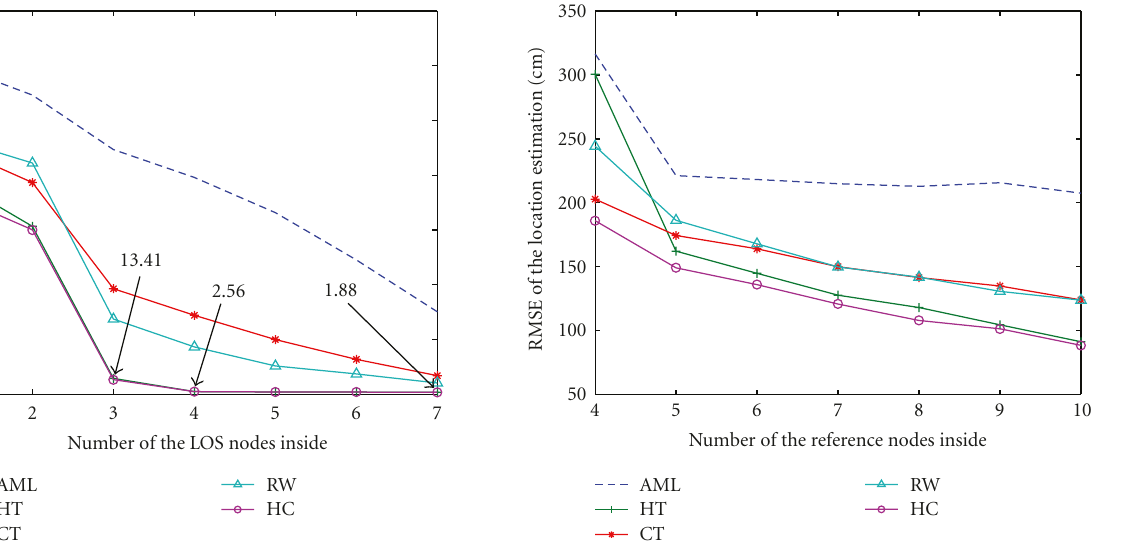
Figure 8: Performance of the methods depending on the number of reference nodes. The number of the NLOS nodes is a random variable. 1000 trials have been